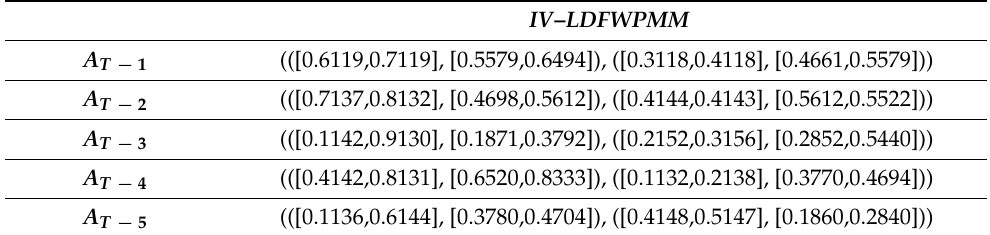
Table 3. The aggregated values.